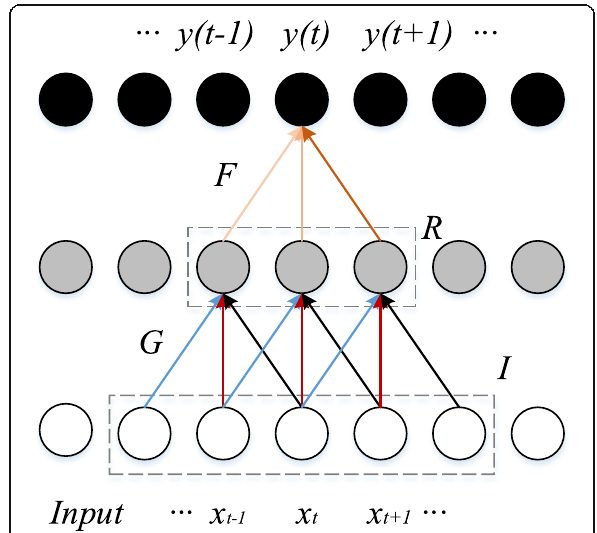
Fig. 2 Fully convolutional layer network structure. Fully convolutional network preserves local information to generate high-frequency components, and each output sample in FCN relates only locally to the neighboring input regions rather than the total input